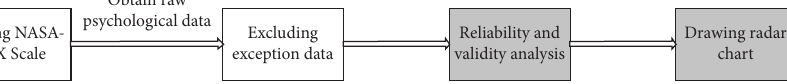
Figure 7: Psychological data analysis flow diagram.